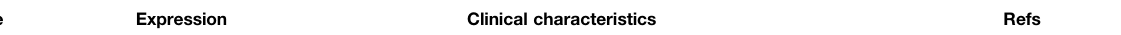
TABLE 1 | LINC00707 expression and clinical characteristics in diverse diseases.